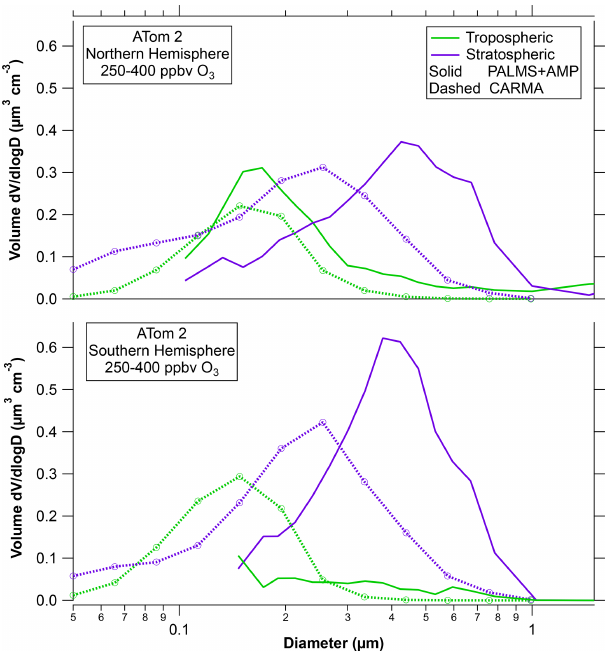
Figure 2. A comparison of the CARMA bin microphysics aerosol model in the CESM climate model with observed size distributions during ATom2. Total particle volumes are proportional to areas un- der each curve. The PALMS stratospheric particles are the sulfu- ric acid and meteoric-sulfuric acid types. Tropospheric particles are mixed organic–sulfate particles and less common other types. The model tracks stratospheric and tropospheric particles